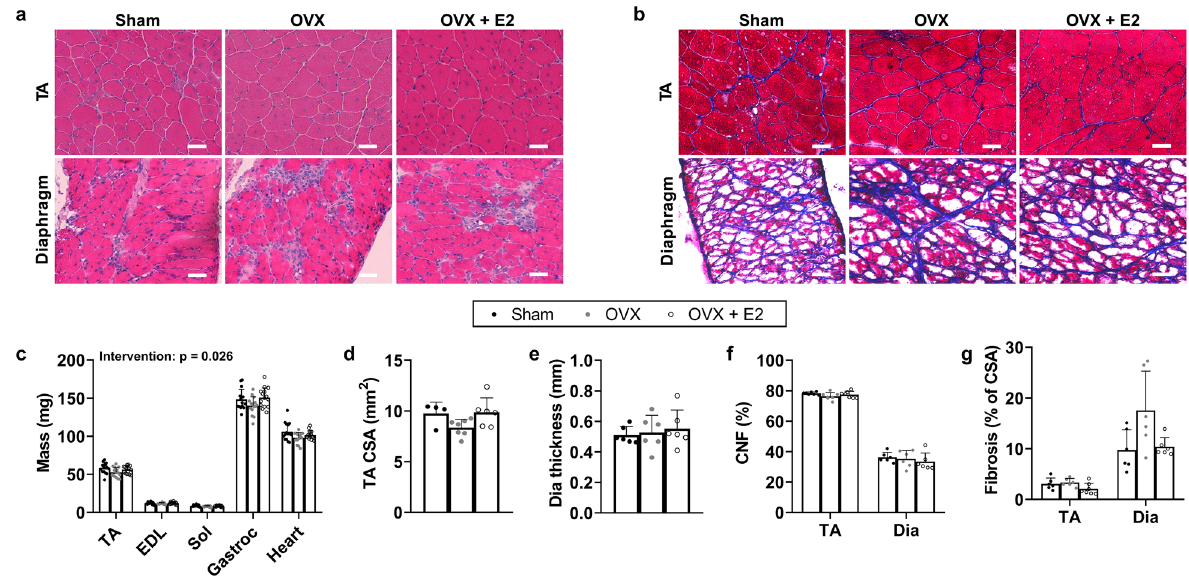
Figure 5. The effect of ovariectomy on skeletal muscle mass, morphology and histology in female mdx mice. ( a ) Representative H&E sections and ( b ) trichrome staining for collagen (blue) of the tibialis anterior (TA) and diaphragm muscle in sham-operated (sham; laparotomy without removal of the ovaries), ovariectomized (OVX) and OVX + oestradiol (OVX + E2) female mdx mice. ( c ) Striated muscle mass, ( d ) TA cross-sectional area (CSA), ( e ) diaphragm (Dia) thickness, ( f ) central nucleated fibers (CNF) and ( g ) collagen content (fibrosis) in sham, OVX and OVX + E2 female mdx mice. N = 5–15/group. Scale bar is 50 µm. Muscle masses were analysed using a repeated measures two-way ANOVA with Tukey’s post‑hoc analysis, TA CSA, TA CNF, Dia CNF and Dia fibrosis were analysed by Kruskal–Wallis test with Dunn’s post‑hoc analysis, and TA fibrosis and Dia